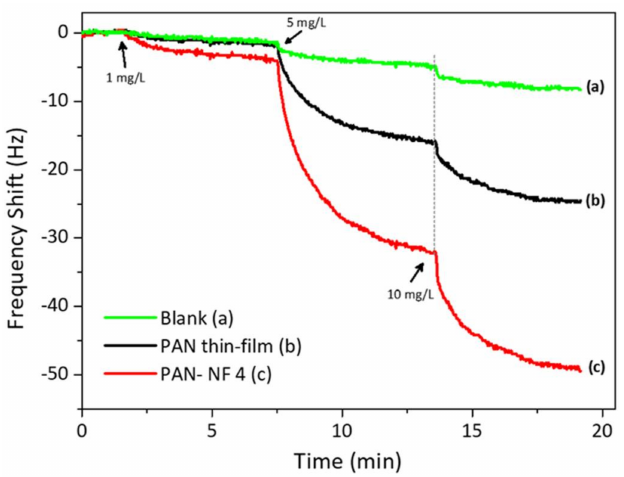
Figure 5. The QCM response to safrole of bare, modified with PAN by spin-coating and modified with PAN by electrospinning.